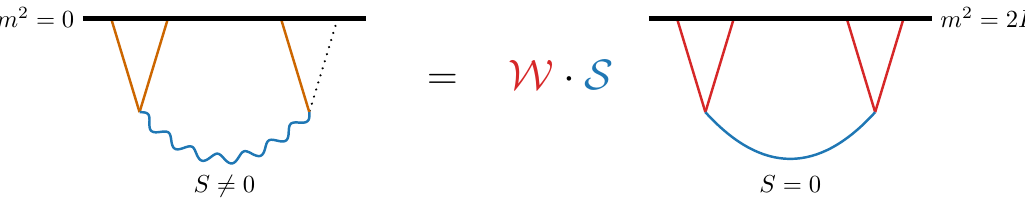
Figure 1. Schematic illustration of the spin-raising and weight-shifting procedure studied in this